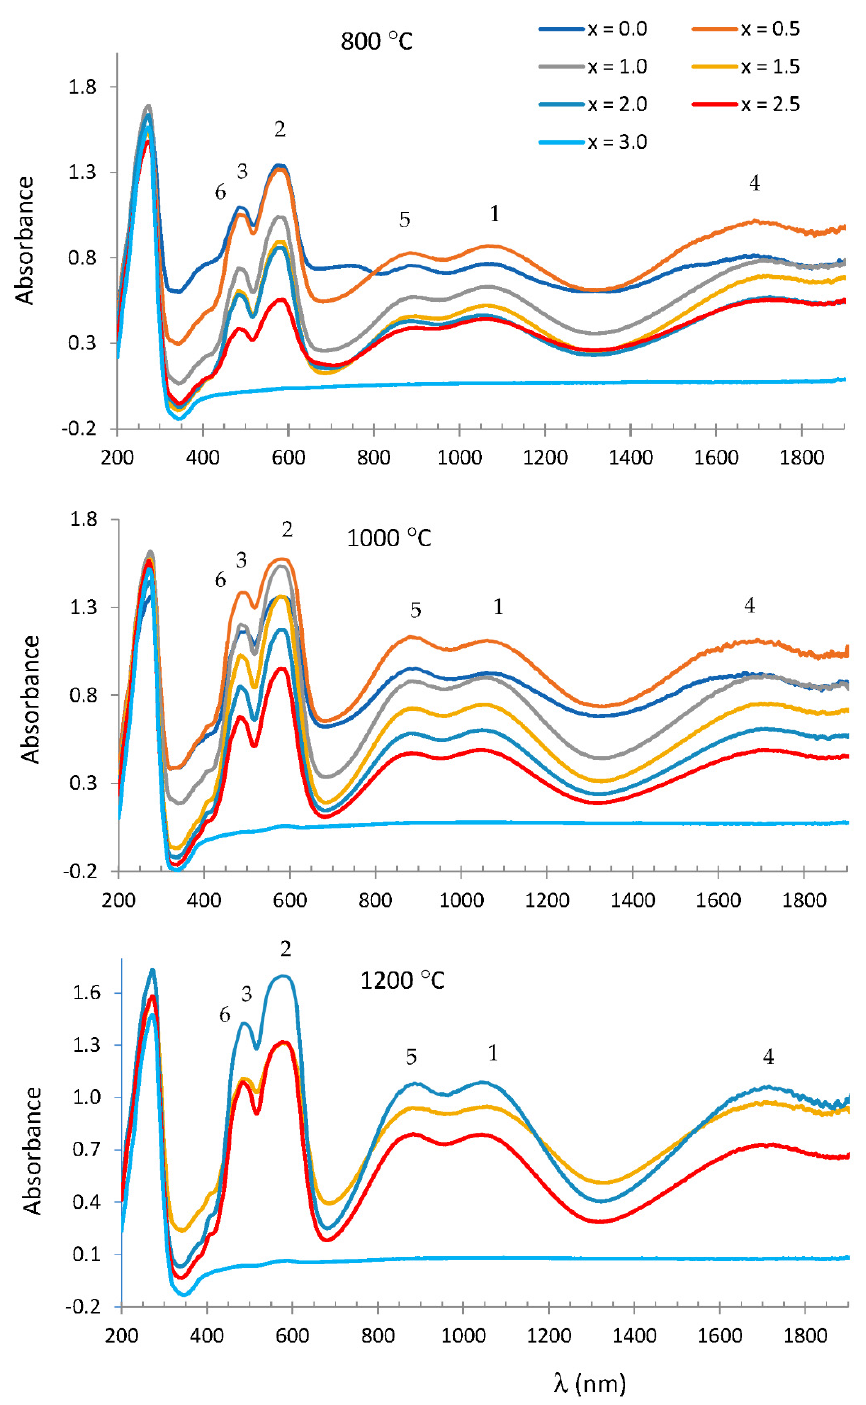
Figure 6. UV–vis–NIR spectra of Mg x Co 3 − x P 2 O 8 fired at 800, 1000 and 1200 °C. Co(II) CN = 6: (1) 4 T 1 4 T 2 , (2) 4 T 1 4 A 2 , (3) 4 T 1 4 T 1 (P). Co(II) CN = 5:, (4) 4 A 2 4 A 1 , (5) 4 A 2 4 E, (6) 4 A 2 4 E(P).